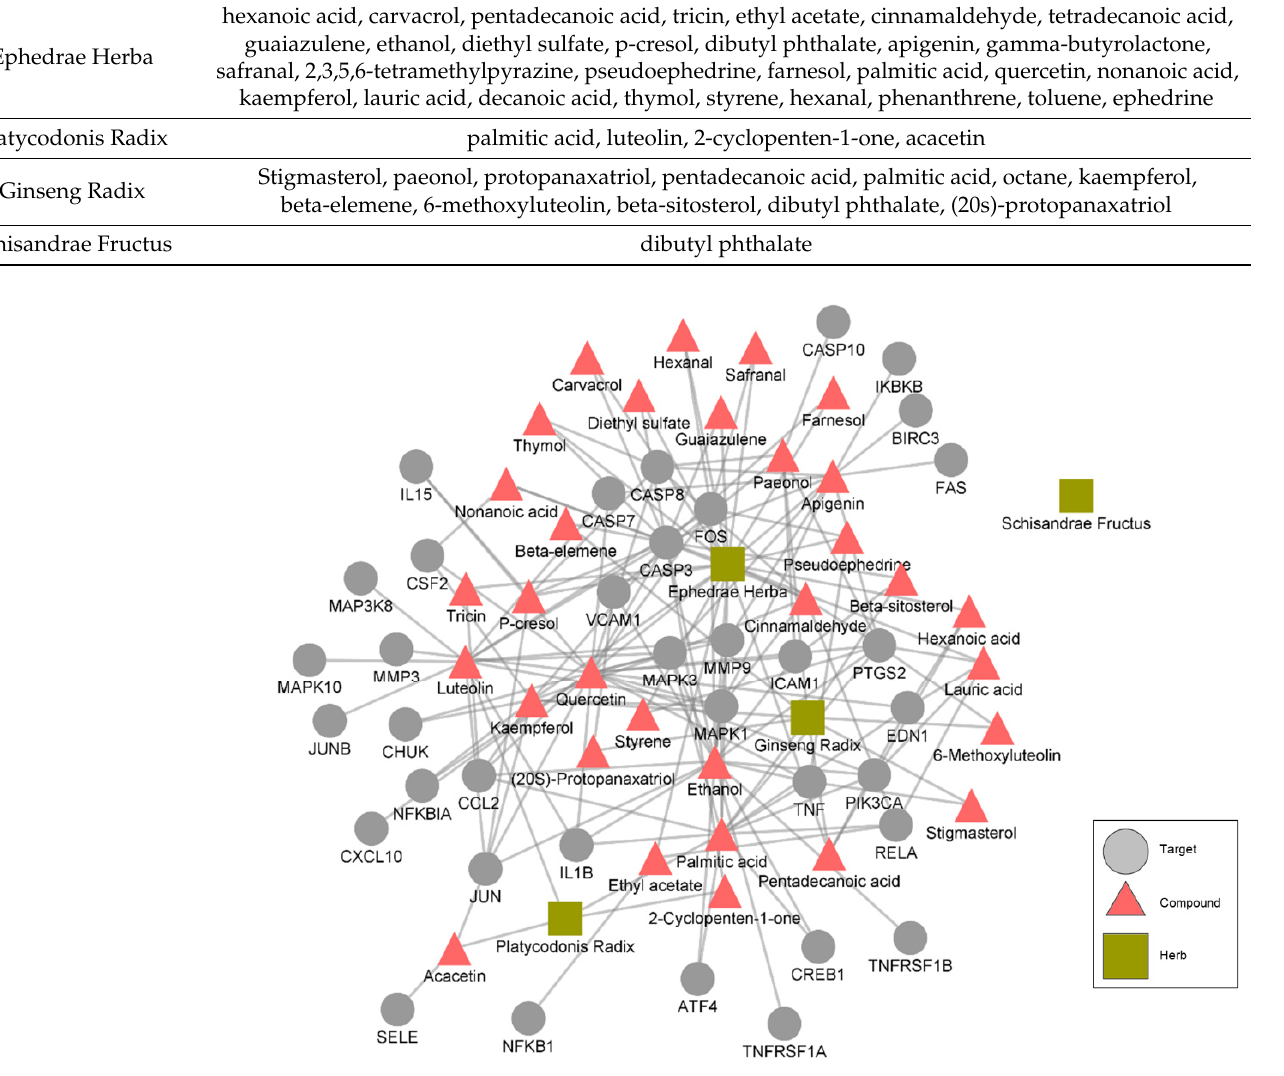
Figure 3. A herb-compound-target network that is specific to the TNF signaling pathway. The tar- gets that represent the “target” nodes are proteins related to the TNF signaling